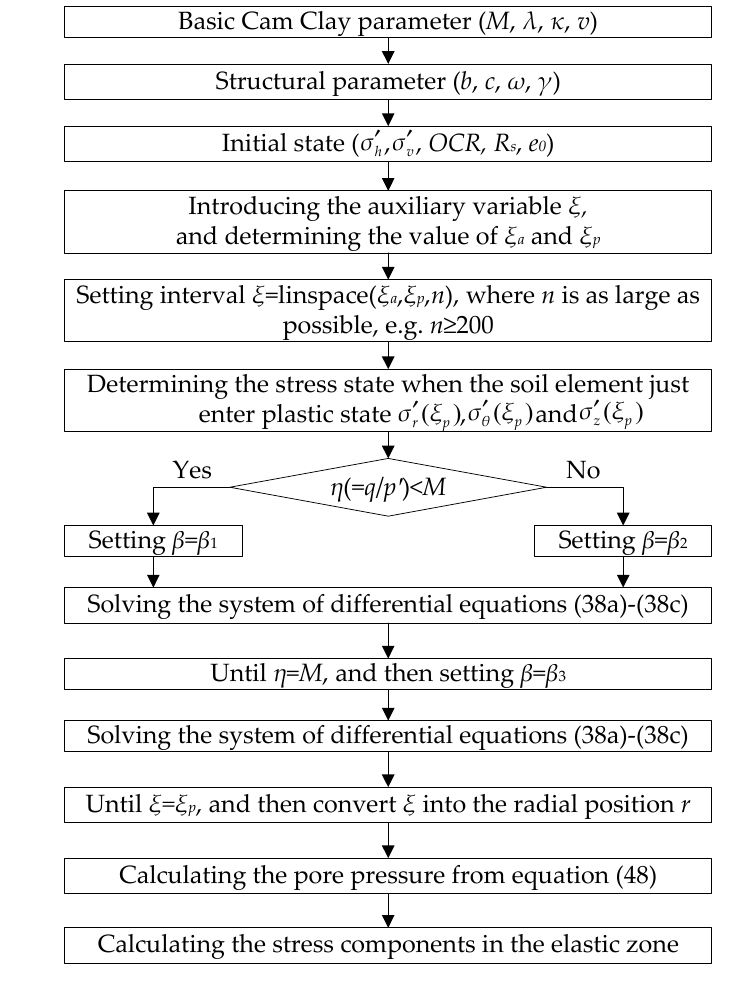
Table 1. Soil property parameters used in calculation.